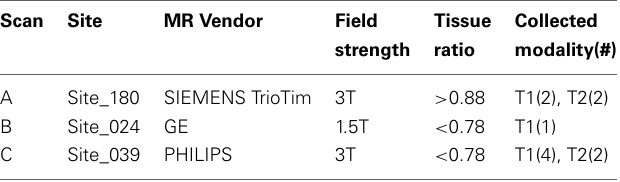
BRAINSABC were highly agreeable to Atropos and FreeSurfer in cortical area in general. For subcortical area (blue box), however, BRAINSABC produced more agreeable to FreeSurfer than Atropos. Atropos were the most conservative in the subcortical GM identification among three methods. For CSF (or ventricle) region, which is more distinguishable from T2-weighted modality, BRAINSABC produced very robust results across